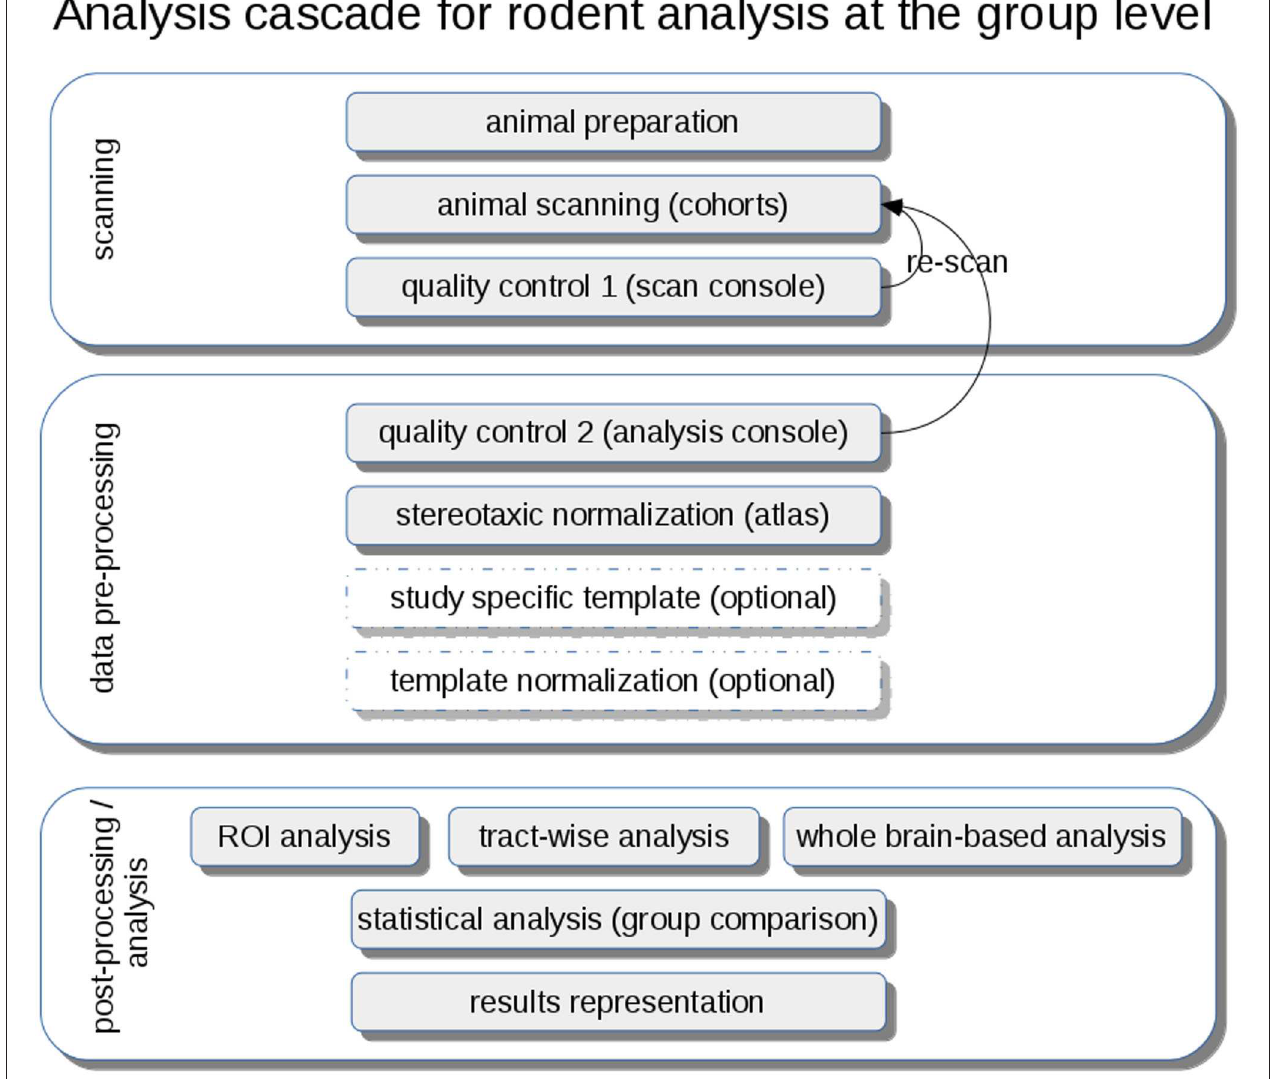
FIGURE 4 | Analysis cascade for rodent analysis at the group level. After animal preparation and scanning, quality control could be performed first at the scan console and second during the pre-processing at the analysis console with the option of re-scanning of low-quality data sets. A stereotaxic normalization to atlas coordinates can be refined by the creation of study-specific templates and a subsequent template normalization. Analysis at the group level can be performed by hypothesis-guided ROI analysis or tractwise analysis or by unbiased whole brain-based analysis, each followed by a statistical analysis extracting and representing significant results using a pre-defined significance